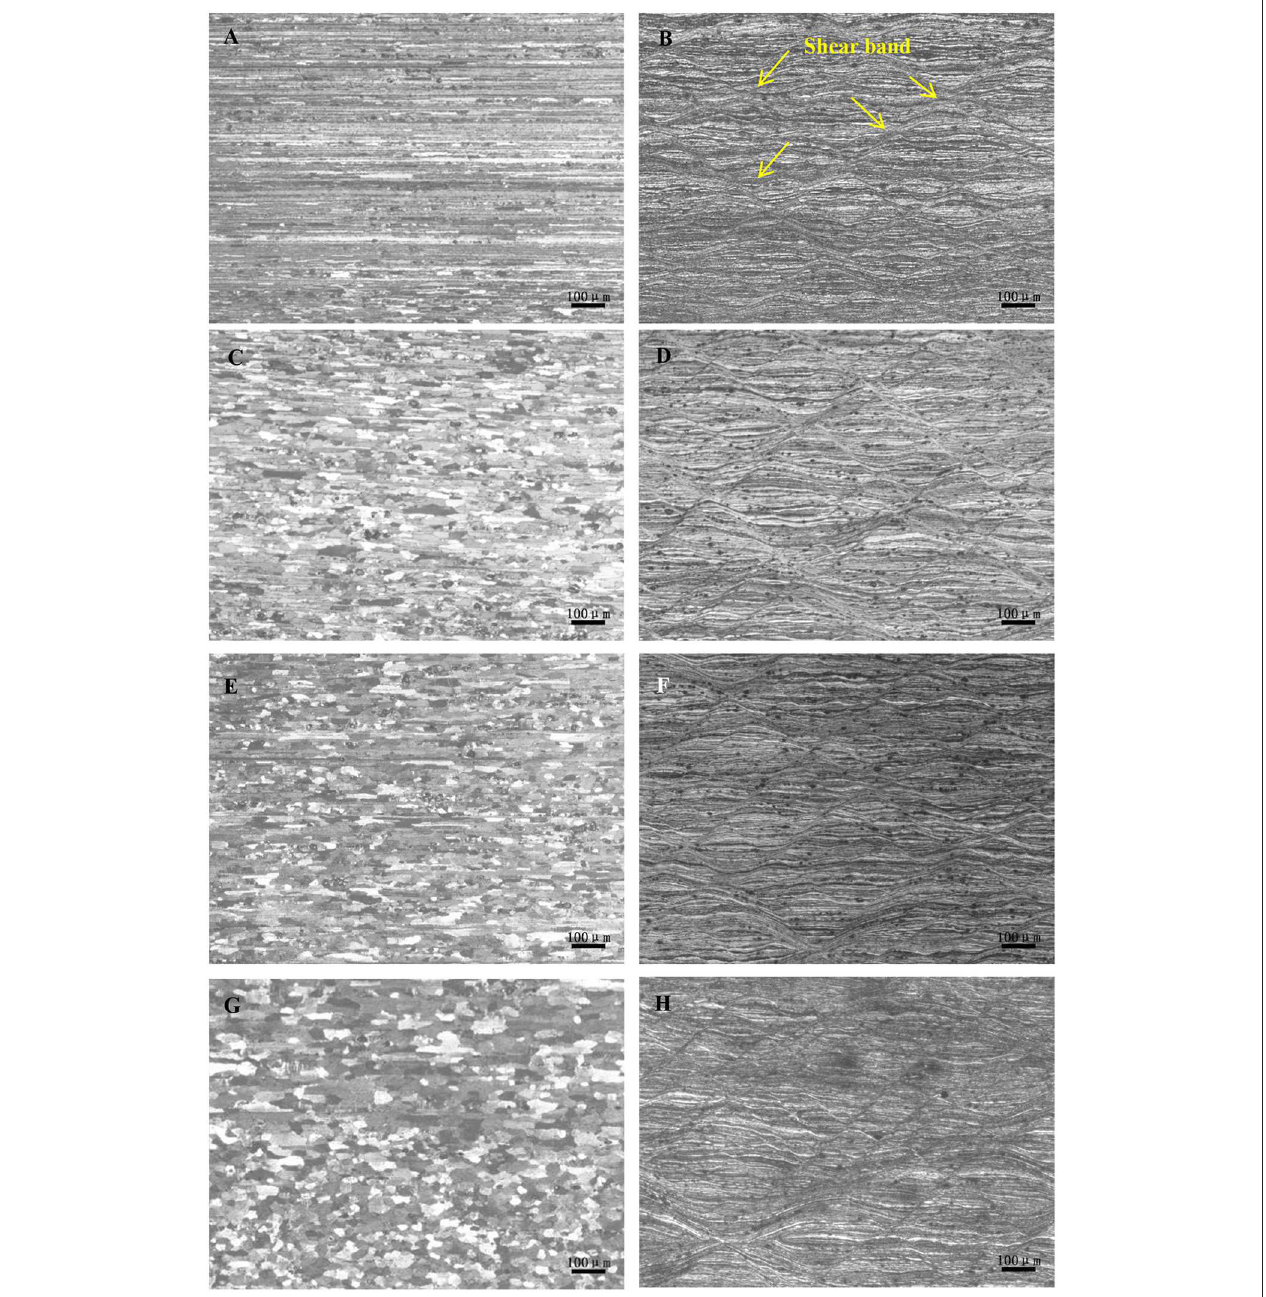
FIGURE 2 | Microstructures of the cold rolling plates of the Sc-free alloy and Sc-containing alloy annealed at different temperatures. (A) Sc-free, cold rolled; (B) Sc-containing, cold rolled; (C) Sc-free, 200 ◦ C anneal; (D) Sc-containing, 200 ◦ C anneal; (E) Sc-free, 350 ◦ C anneal; (F) Sc-containing, 350 ◦ C anneal; (G) Sc-free, 420 ◦ C anneal; (H) Sc-containing, 420 ◦ C